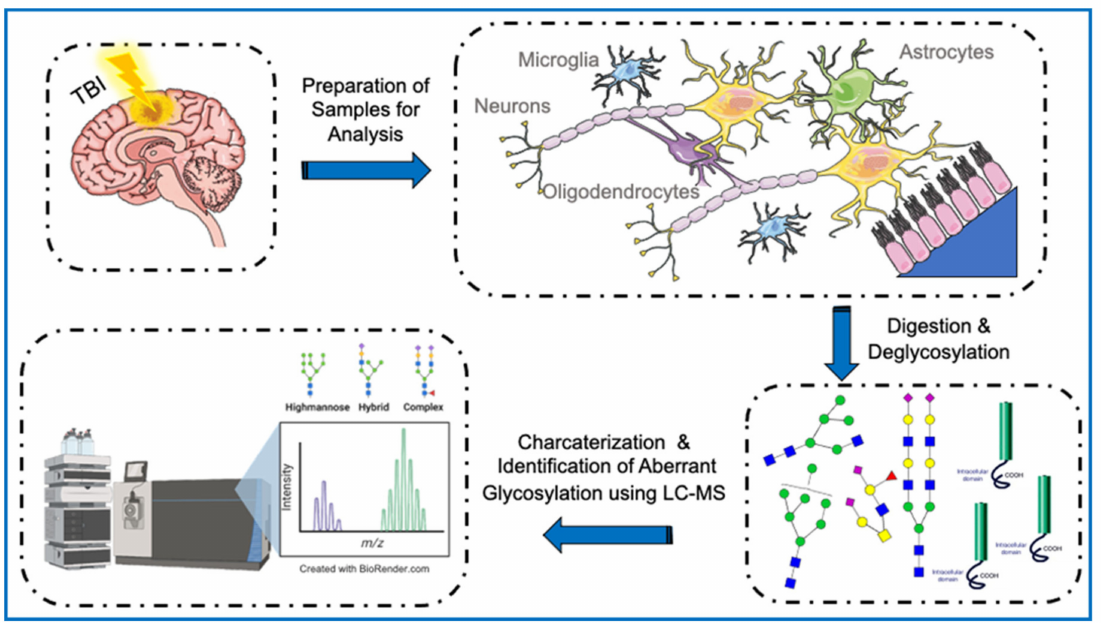
Figure 3. An overview of the after-effects of TBI on the neurological components of the brain, ultimately leading to aberrant glycosylation as shown by MS-based glycoproteomics. TBI: traumatic brain injury, MS: mass